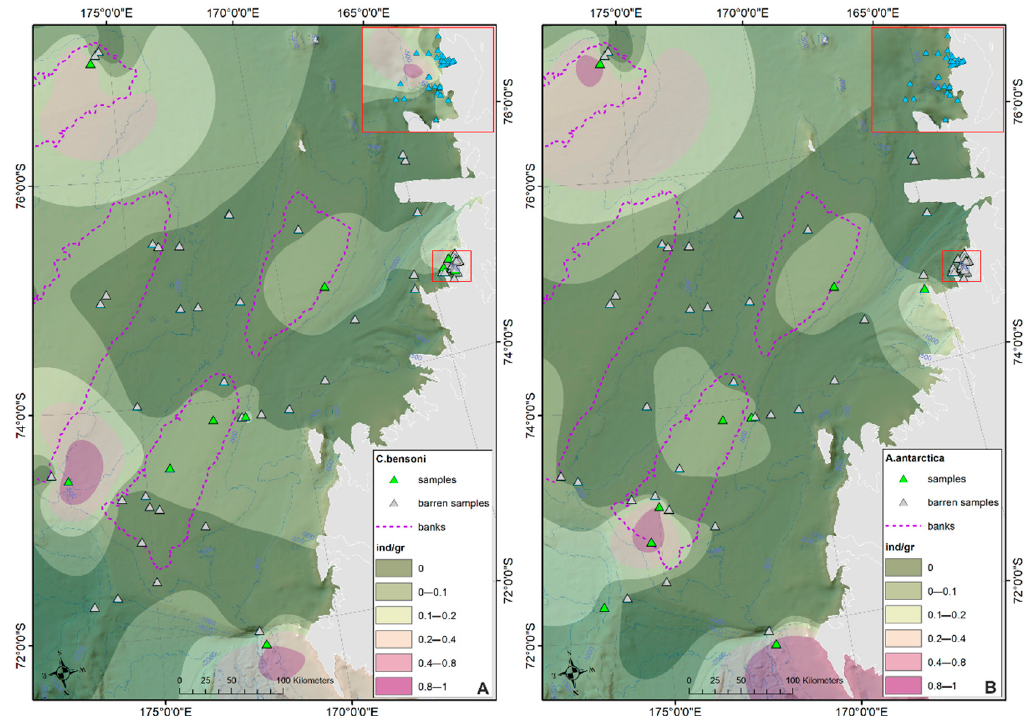
Figure 11. GIS predictive C. bensoni ( A ) and A. antarctica ( B ) distribution maps interpolated in GIS, applying the spline method using barriers. Isobaths every 500 m.